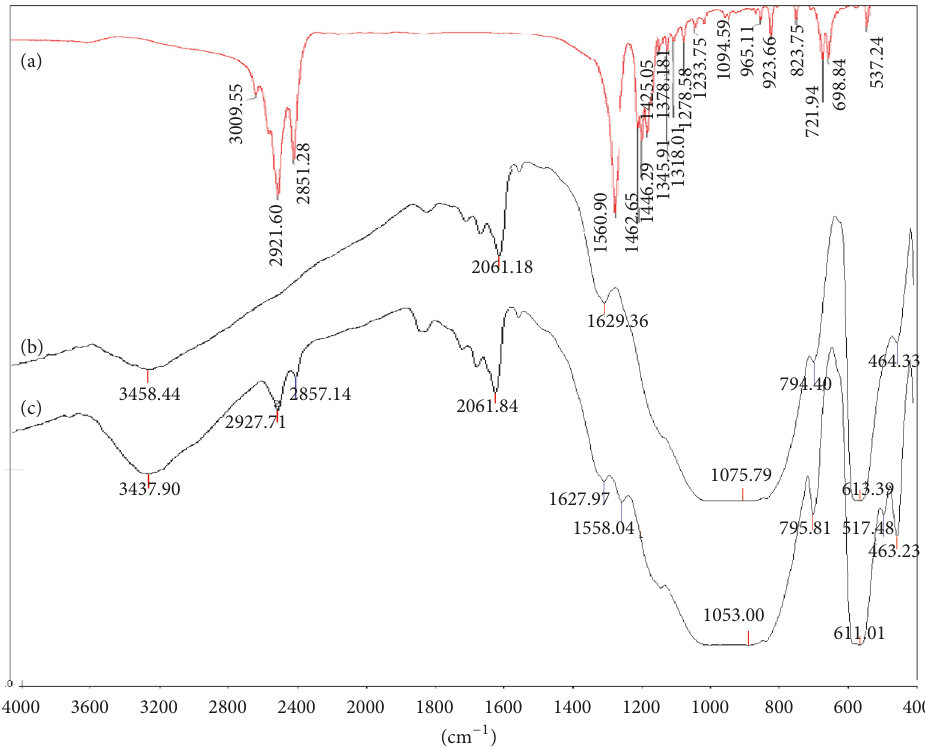
Figure 6: IR of TiO 2 modified by sodium oleate. (a) Sodium oleate; (b) TiO 2 ; (c) modified TiO 2